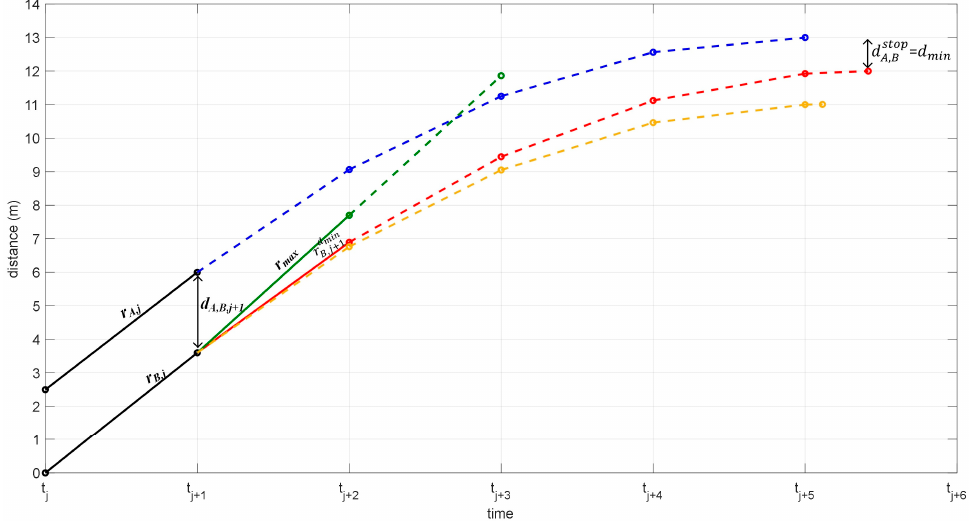
Figure 2. Distance between UAV A and UAV B on different acceleration rates. The lines represent the acceleration rates of UAV A and UAV B at different time steps. A dashed line in the figure means the UAV decelerates at dr max . The blue lines represent the acceleration rates of UAV A , slowing down from t j + 1 until it stops. The yellow lines represent the acceleration rates of UAV B , slowing down from t j + 1 until it stops. The red lines represent the acceleration rates of UAV B , slowing down starting at t j + 2 until it stops. The value of d stop is equal to d min when UAV A and UAV B follow the acceleration rates represented by the blue and yellow lines respectively. The green lines represent the acceleration rate of UAV B when r B , j + 1 is equal to r max and then it decelerates using dr max at t j + 2 . In this case, UAV B collides with UAV A before t j + 3